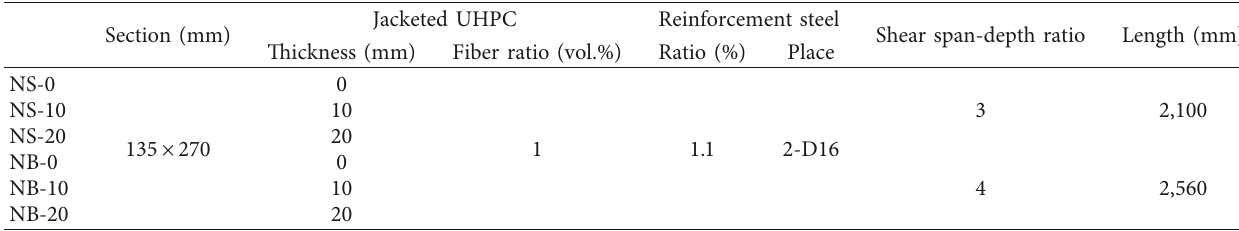
Figure 5: Strain gauge locations. Table 12: The list of NSC beam jacketed UHPC